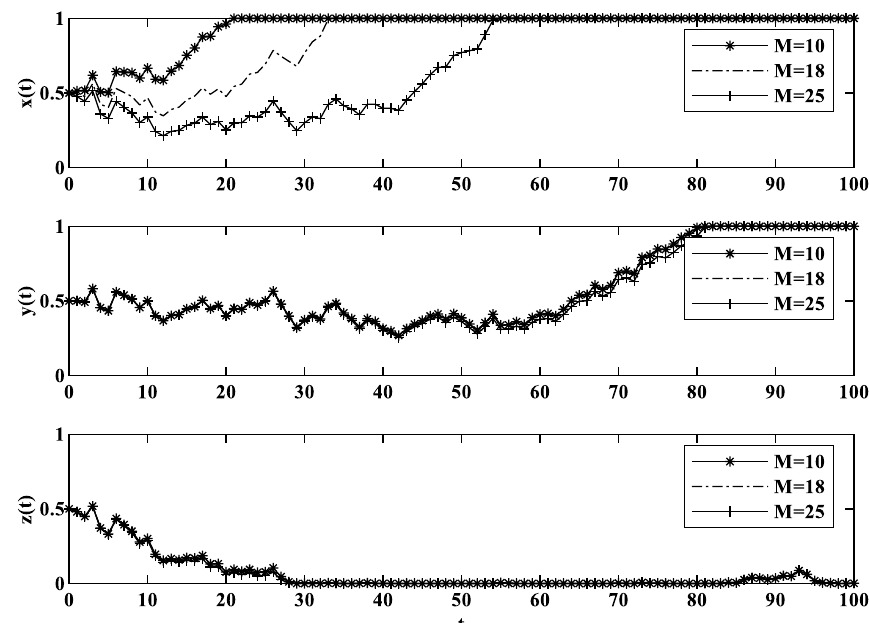
Fig. 11 Impact of illegal penalties on evolutionary process under scenario